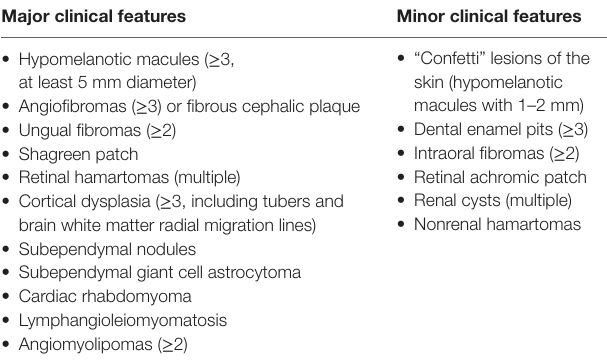
TABLe 5 | Diagnostic criteria of tuberous sclerosis complex [adapted from Ref.